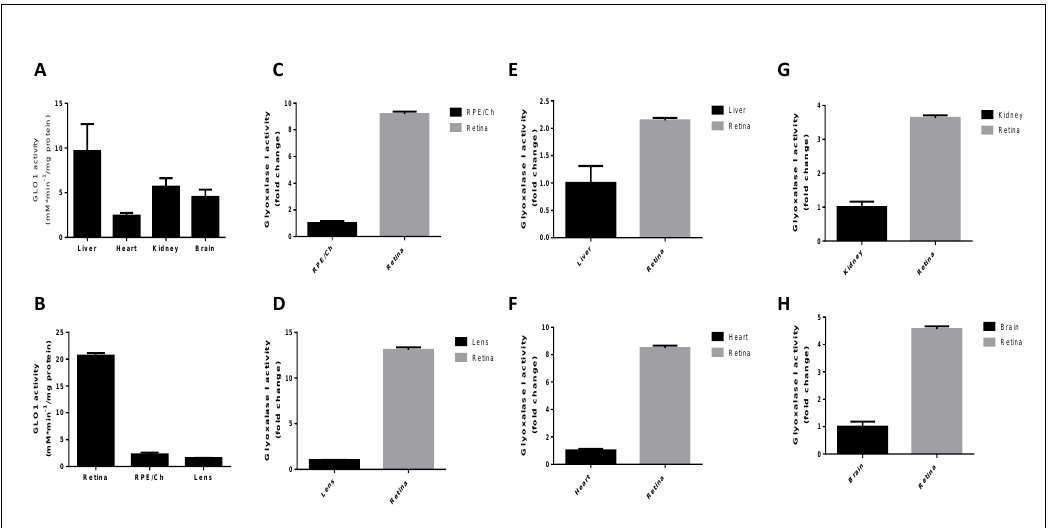
Glyoxalase system and DR.-Figure 5 Figure 5. Evaluation of glyoxalase system activity in ocular and non-ocular tissues. Glyoxalase I activity was determined spectrophotometrically using 1 mL quartz cuvettes by following the initial rate of formation of S-D-lactoylglutathione. The assay mixture containing the glycating reagent MG and reduced GSH was equilibrated at room temperature for 10 min, to ensure hemithioacetal formation. The reaction was initiated by the addition of 20 µ g of cytosolic extract and the A240 was monitored immediately and over the course of 5 min. The reaction rate was determined by following the increase in absorbance at 240 nm for which ∆ ε 240 = 2.86 mM − 1 cm − 1 . (A,B) Glyoxalase I activity was assayed